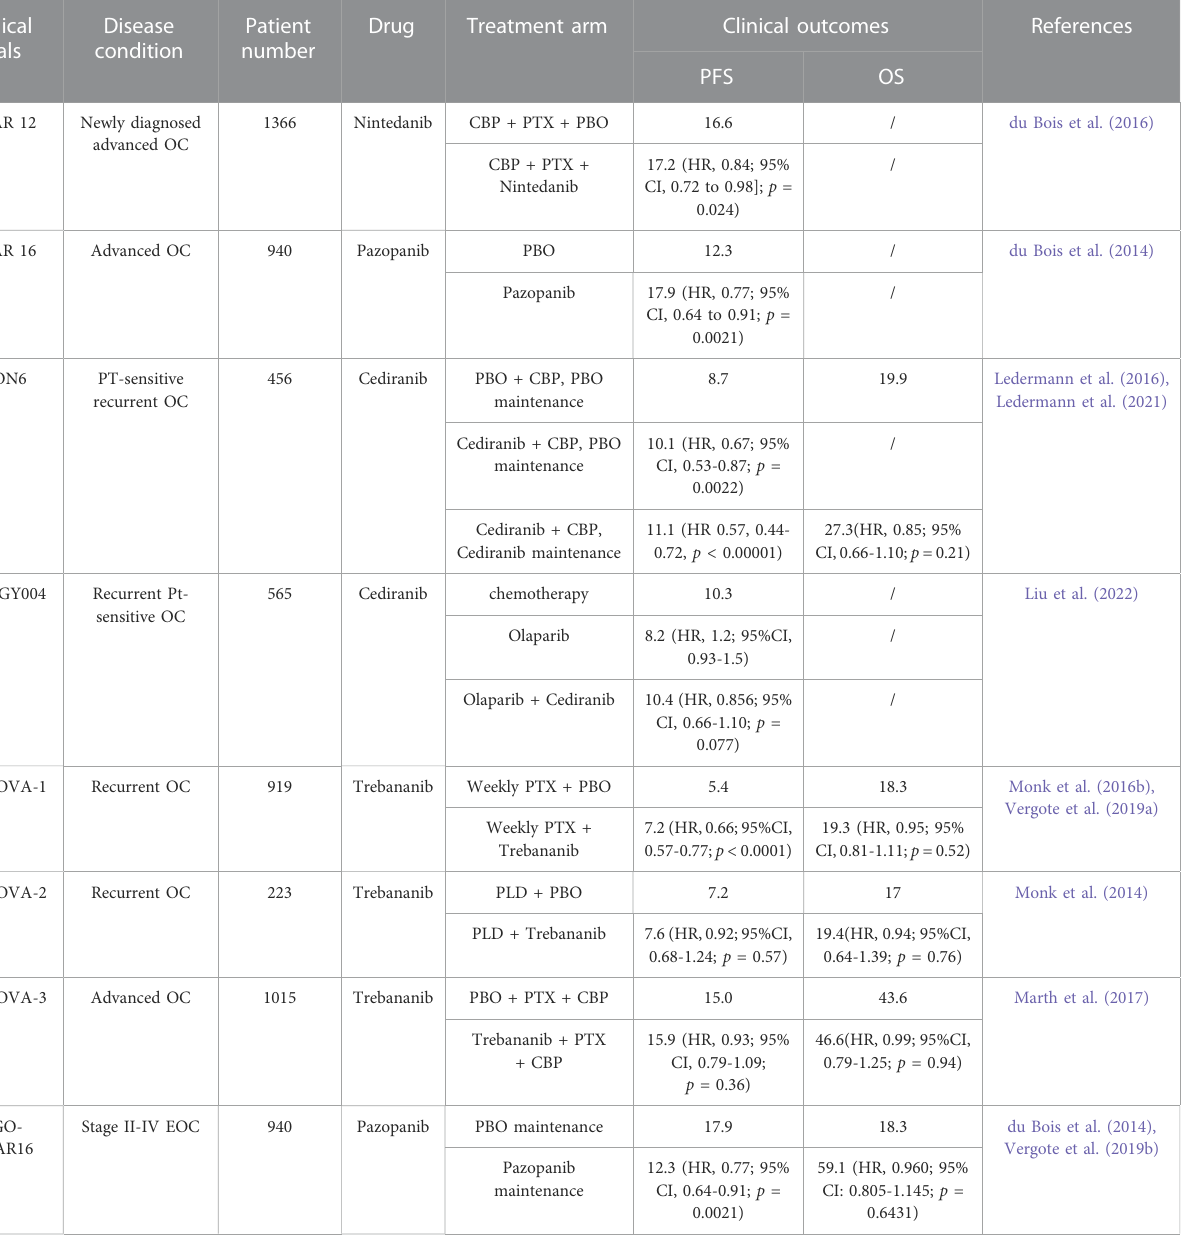
TABLE 2 Summary of phase III studies of antiangiogenic agents in OC. Clinical